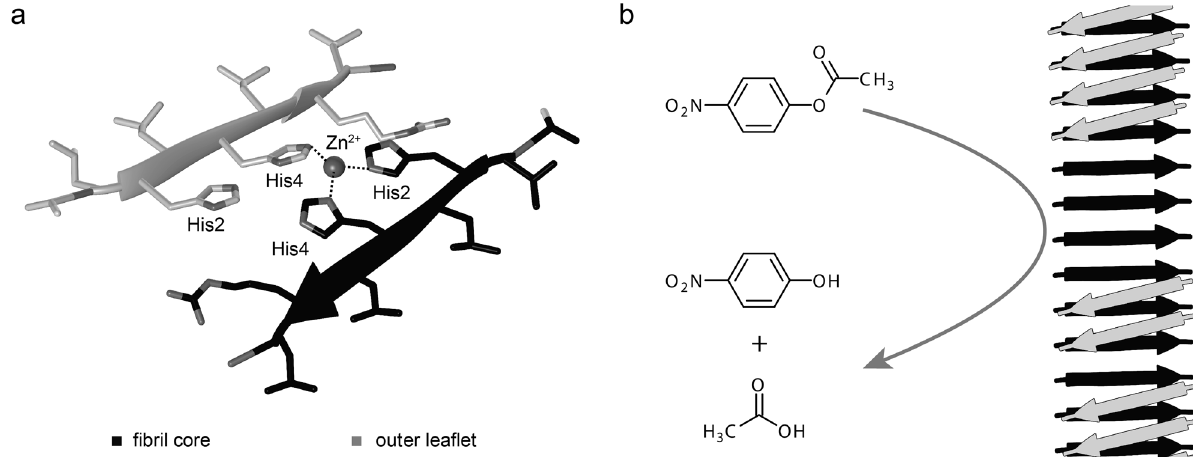
Figure 5. Molecular model of the zinc binding site. ( a ) Molecular arrangement of the Zn 2+ binding site, formed by a peptide from the fibril core (black) and from the outer leaflet (grey). The distance between the nitrogen atoms of the imidazole groups and the Zn 2+ ion is, along the dotted lines, approximately 2 Å. The distances between the Zn 2+ complexing nitrogen atoms are between 3.3 and 3.6 Å. ( b ) Gaps in the outer leaflet of the amyloid fibril allow access of the substrate to the catalytic